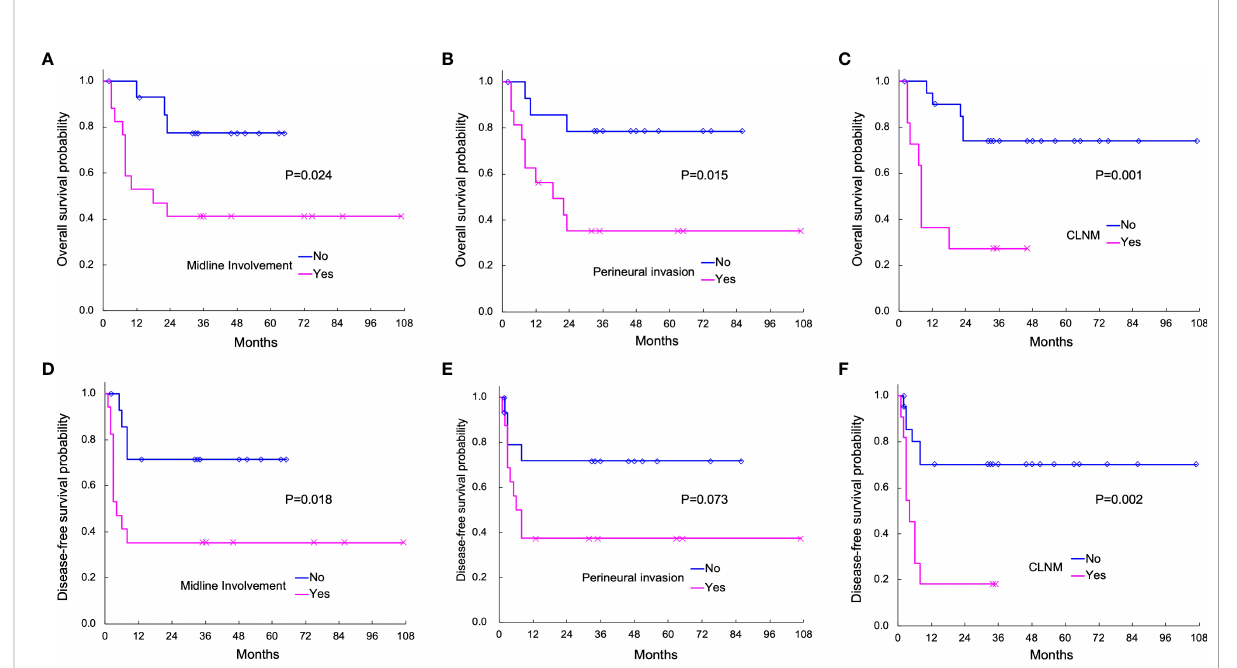
FIGURE 3 Actuarial Kaplan – Meier survival curves of overall survival (OS; A – C ) and disease-free survival (DFS; D – F ) analyzed with the log-rank test. OS according to midline involvement (P = 0.024), perineural invasion (PNI; P = 0.015), and contralateral neck metastasis (CLNM; P = 0.001) is shown in (A-C) , respectively. DFS according to midline involvement (P = 0.018), PNI (P = 0.073), and CLNM (P = 0.002) are displayed in (D-F) ,